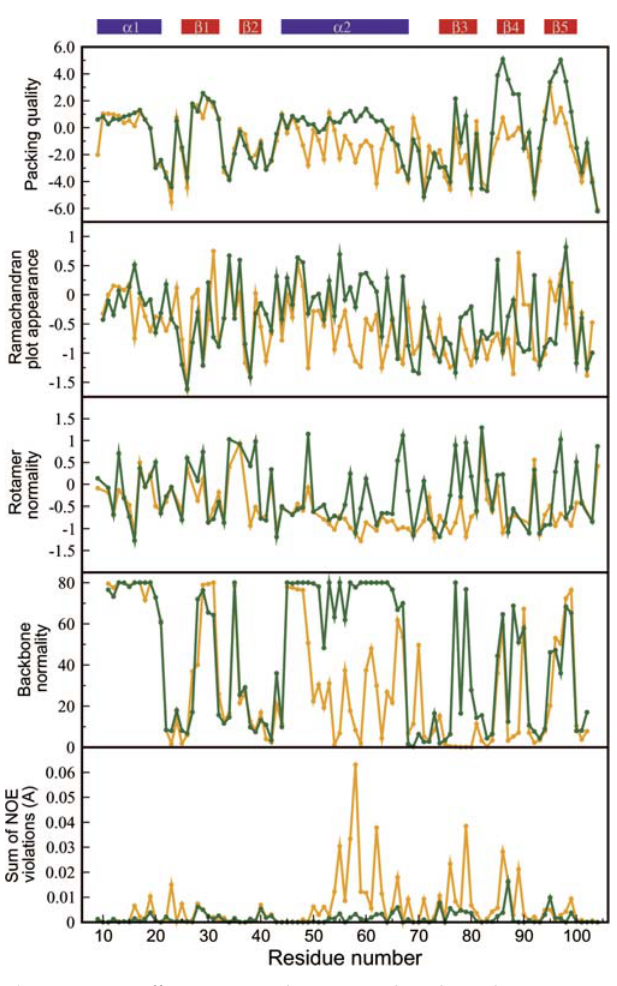
Figure 2. Five Different per-Residue Structural Quality Indicators (A) Packing quality Z -score. (B) Ramachandran plot appearance Z -score. (C) Rotamer normality Z -score. (D) Backbone normality score. The values listed on the y -axis indicate the number of times the local backbone (defined by the current residue plus or minus two residues) was found in WHAT IF’s internal database (with a cut-off on the number of hits at 80). (E) Sum of the NOE violations. Scores for the refined 1Y4O ensemble are shown in green; those for the refined 1TGQ ensemble are shown in orange. Secondary structure of the 1Y4O ensemble is indicated using colored boxes: a -helices are shown in blue, b -strands are shown in red. DOI: 10.1371/journal.pcbi.0020009.g002